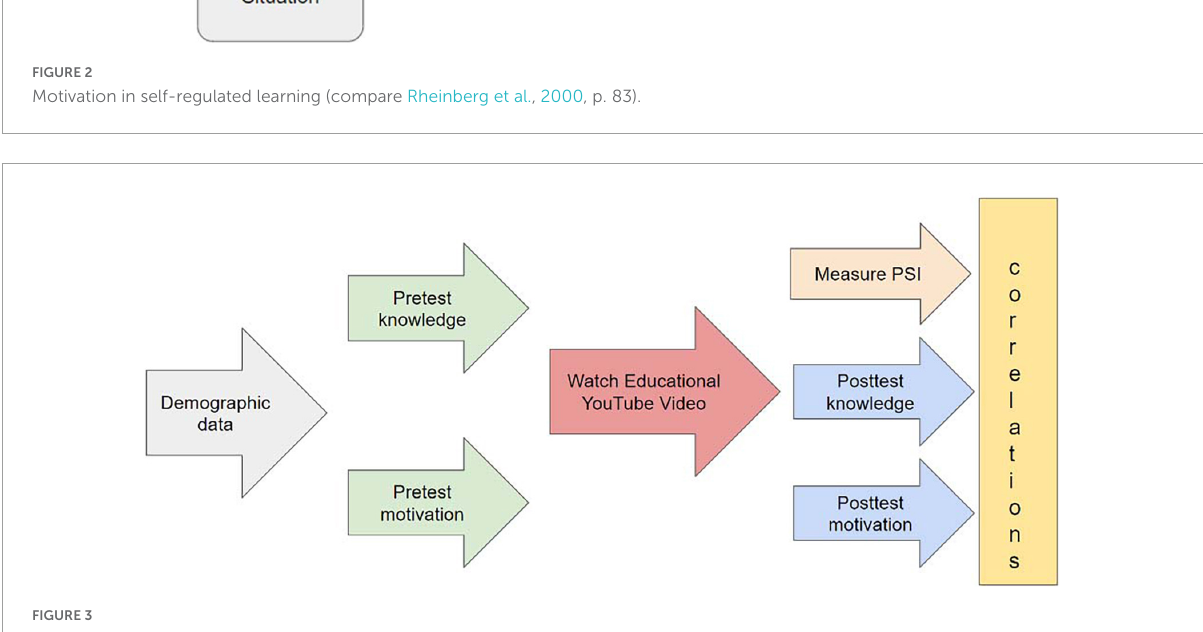
FIGURE3 Research design.